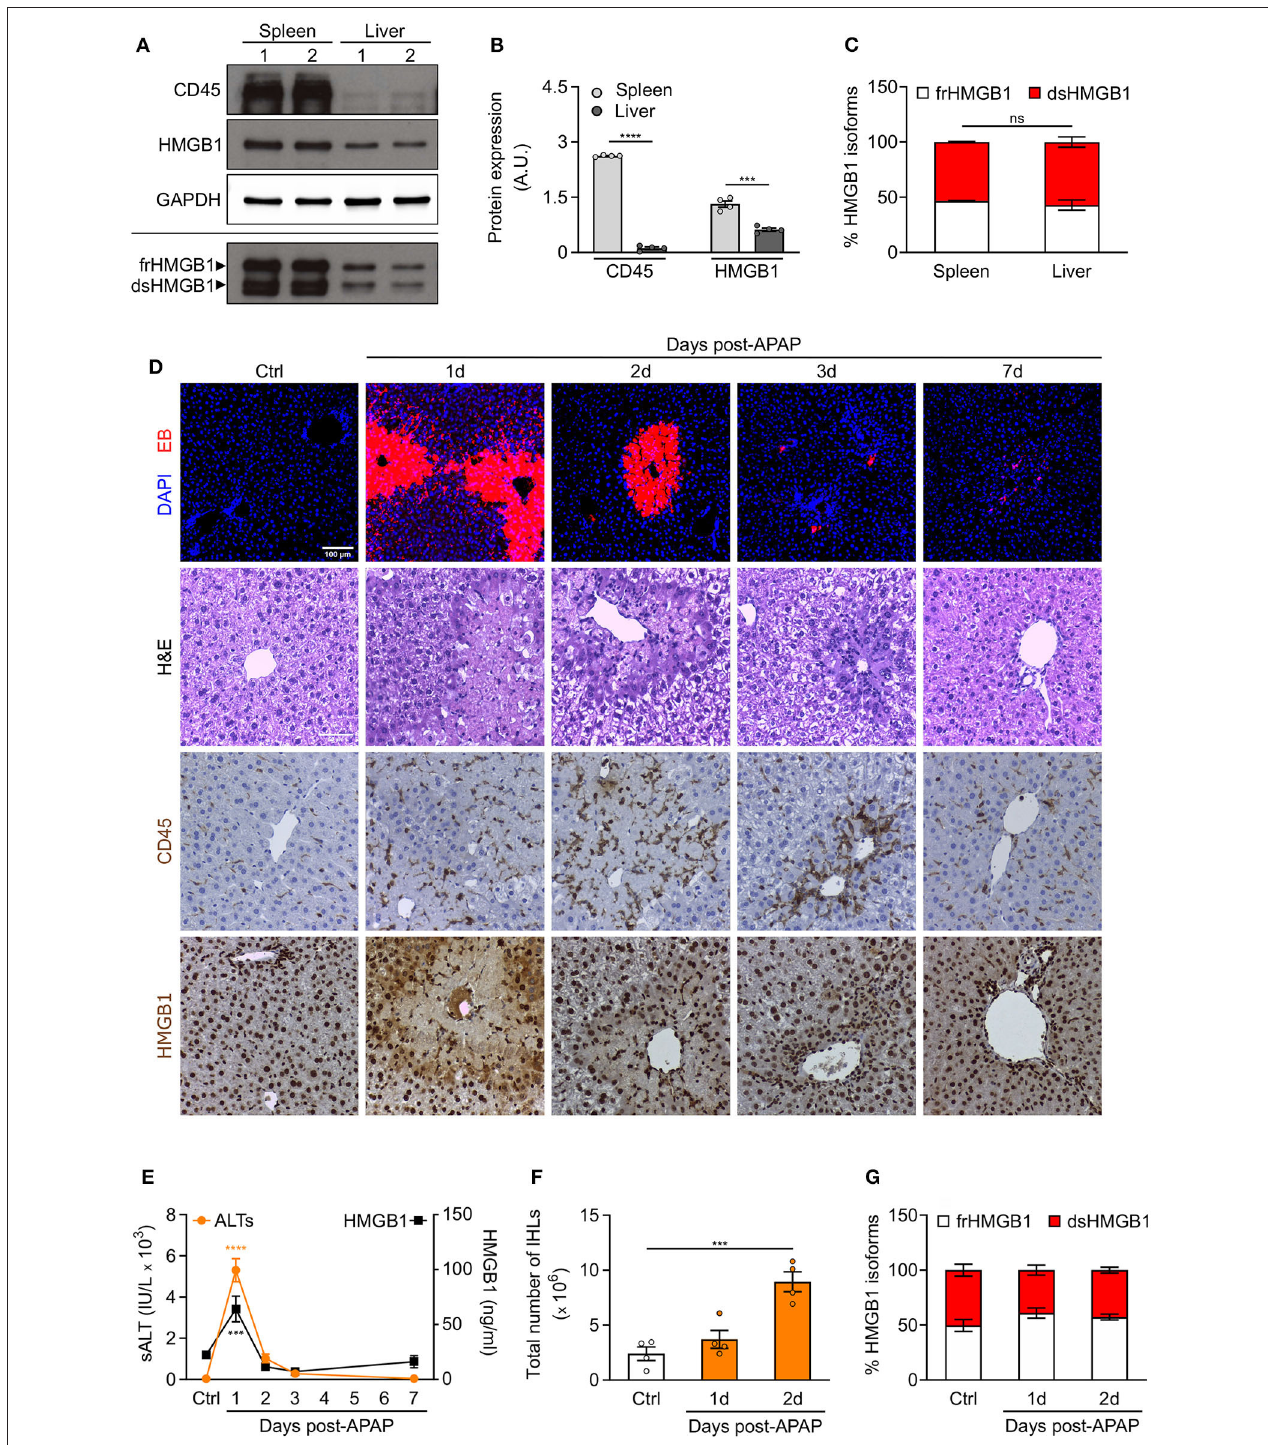
FIGURE 5 | Redox modulation of HMGB1 in spleen and in drug-intoxicated liver. (A) Western blot probed with anti-CD45, anti-HMGB1, and anti-GAPDH antibodies in reducing conditions (upper panels) or probed with anti-HMGB1 antibody in non-reducing conditions (lower panel) on lysates of spleen and liver isolated from control WT mice. In the lower panel, the upper band corresponds to the fully reduced-HMGB1 (frHMGB1) and the lower band to the disulphide-HMGB1 (dsHMGB1). (B,C) Quantification of total CD45 and HMGB1 protein levels normalized on GAPDH (B) , and HMGB1 redox isoforms percentage (C) in spleen and liver lysates. A.U. = arbitrary unit ( n = 4 mice/group). (D–G) Drug-induced liver injury (DILI) was induced by i.p. injection of acetaminophen (APAP), 300 mg/kg (body weight). Serum